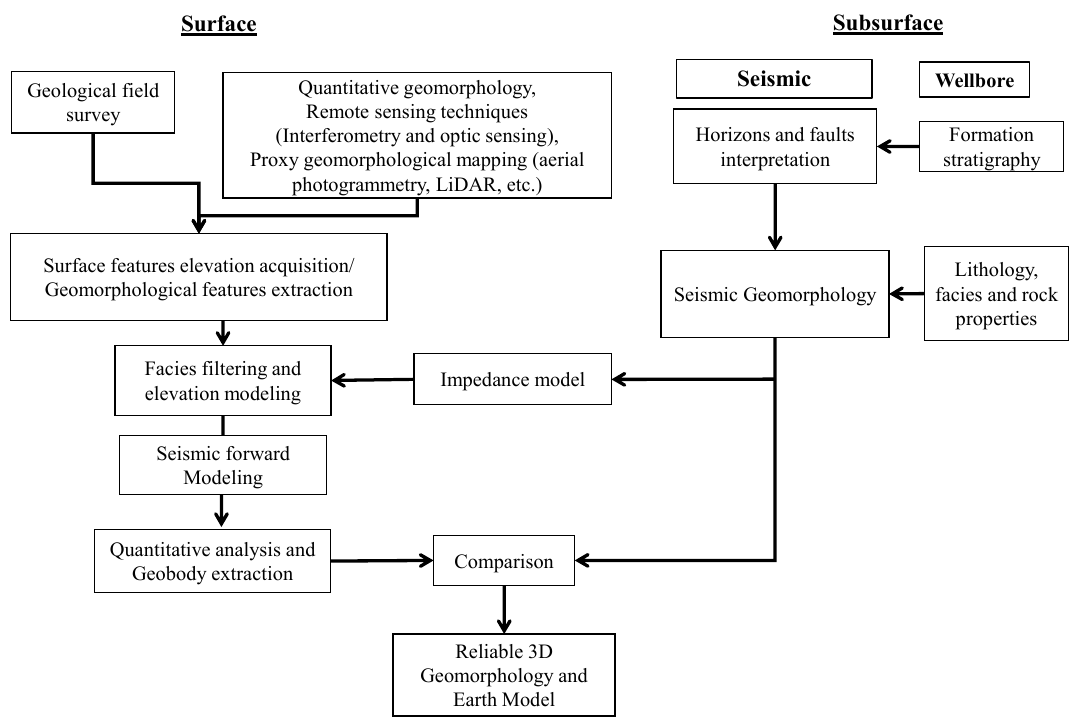
Figure 7. Proposed integrated seismic (with addition of wellbore data, if available) and surface geomorphology workflow for a reliable 3D model of the earth and its geomorphology.